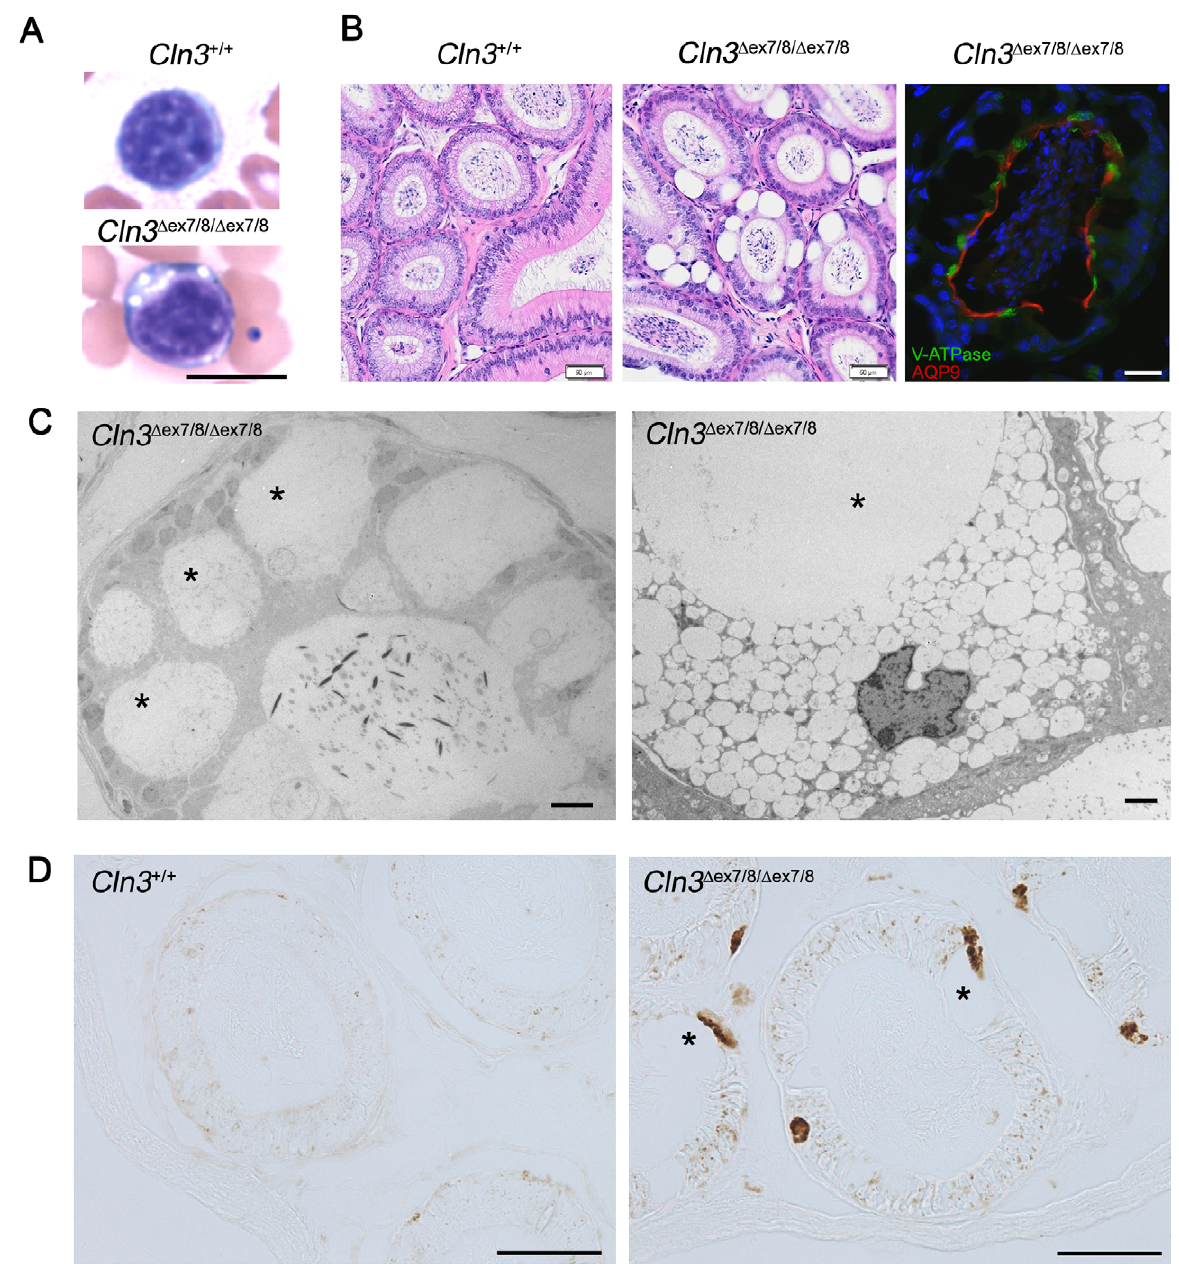
Figure 8. Vacuolation of diverse cell types in homozygous Cln3 D ex7/8 mice. (A) Representative images are shown of Wright-Giemsa stained peripheral blood smears from Cln3 + / + and Cln3 D ex7/8/ D ex7/8 littermate mice (scale bar=10 m m). Note the presence of vacuoles in the cytoplasm of the dark blue stained peripheral blood lymphocyte. (B) Representative images are shown of H&E-stained sections of epididymis from 19-week-old Cln3 + / + and Cln3 D ex7/8/ D ex7/8 littermate male mice (scale bar=50 m m). A representative image of a section of mutant ( Cln3 D ex7/8/ D ex7/8 ) epididymis immunostained for vacuolar ATPase (V-ATPase, green) and aquaporin-9 (AQP9, red), which highlight the apical (luminal) membrane of clear/narrow cells or principal cells, respectively (scale bar=25 m m). (C) Representative TEM images of Cln3 D ex7/8/ D ex7/8 epididymis cross-sections are shown. Note both the giant vacuoles and the multiple smaller vacuoles filling the cytoplasm of the clear cells. Also note the relative absence of electron-dense material inside the vacuoles. Scale bars, left panel=10 m m; right panel=2 m m. (D) Representative images of subunit c immunostained Cln3 + / + and Cln3 D ex7/8/ D ex7/8 epididymis sections are shown. Asterisks (*) mark some of the large vacuoles. Scale bars=50 m m. Blood smears and epididymides from at least 10 mice per genotype were analyzed in total, and abnormal vacuolation was observed in all of the Cln3 D ex7/8/ D ex7/8 mice and in none of the wild-type or Cln3 + / D ex7/8